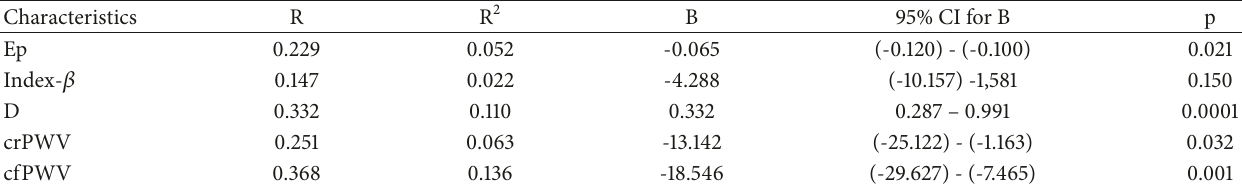
Table 4: Parameters of linear regression equations.